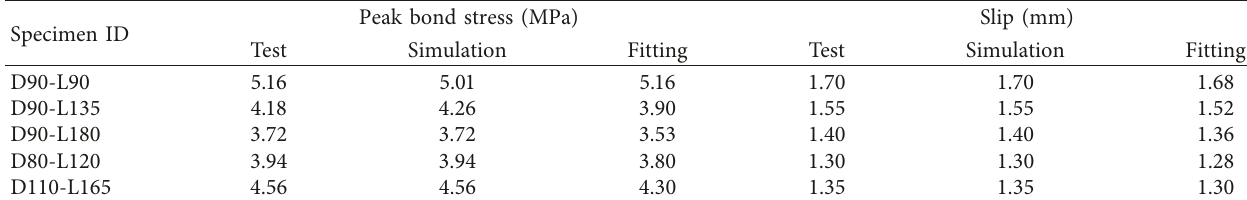
Table 4: Comparison of peak bond stress and